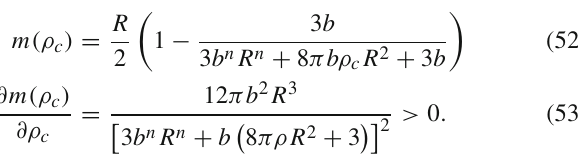
rium. We have also plotted the M – R diagram for the range 7 ≤ n ≤ 12 and it shows that the maximum mass increases with n . For n = 7 the maximum mass is 2.643 M (cid:6) with radius 8.976 km and for n = 12, M max = 3 . 063 M (cid:6) with radius 10.85 km. The profile of adiabatic index (see Fig.